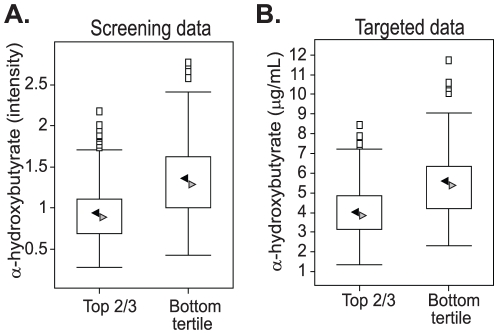
α-HB levels are higher in insulin resistant subjects in both screening and targeted assays.A. Box plot of α-HB levels measured in the non-targeted MS analysis (screening data). The X-axis shows the groups and the Y-axis shows the relative normalized intensity for α-HB median scaled to 1. B. Box plot of α-HB concentrations measured using targeted isotopic dilution assays (targeted data). The X-axis shows the groups and the Y-axis shows α-HB concentration in µg/ml. In the box plots the top and bottom of the box represent the 75th and 25th percentile, respectively. The top and bottom bars (“whiskers”) represent the entire spread of the data points for α-HB and each group, excluding “extreme” points, which are indicated with black squares. The black arrowheads indicate the mean value and the gray arrowheads indicate the median value.